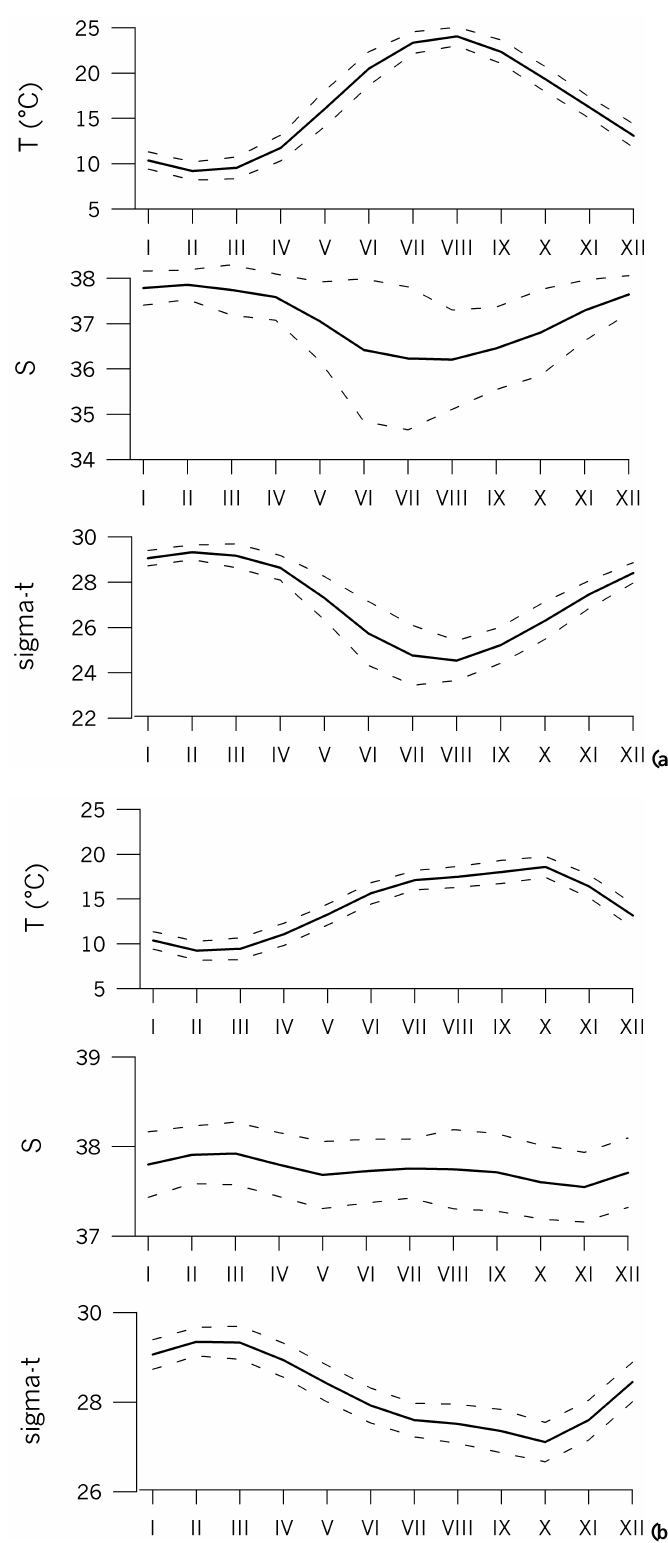
Fig. 3. Average values (solid line) and standard deviations (dashed lines) of temperature, salinity and density (sigma-t) for the 1921–2000 in (a) surface and (b) bottom layer at station